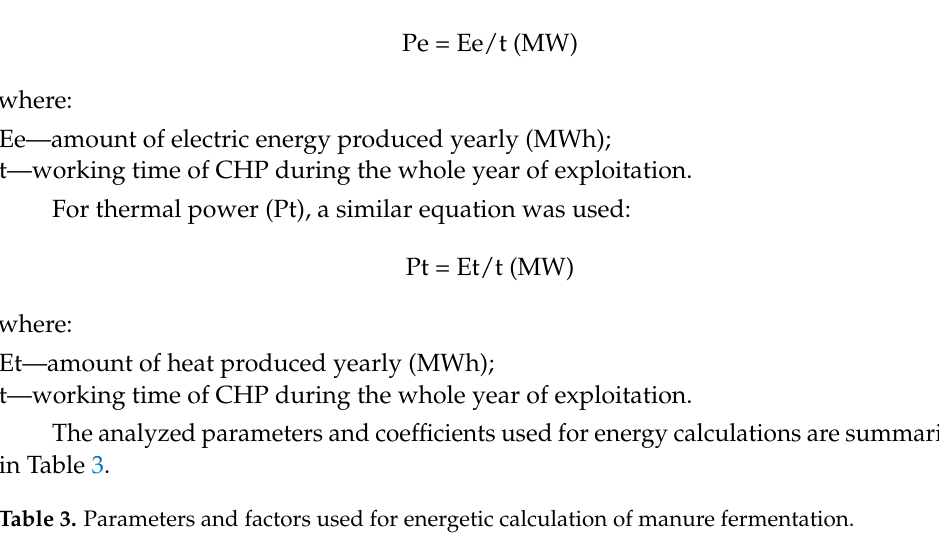
Table 3. Parameters and factors used for energetic calculation of manure fermentation.